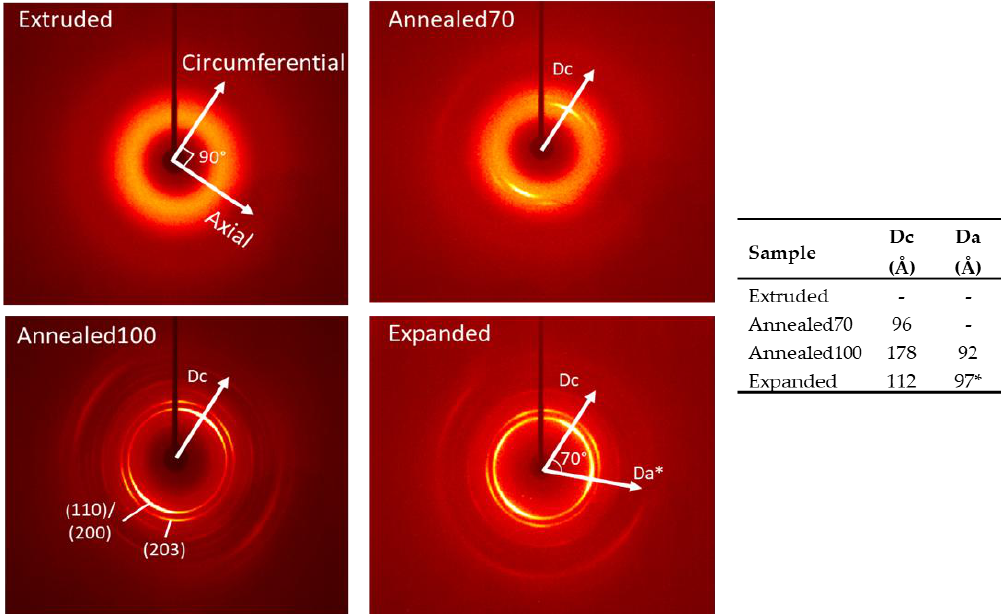
Figure 6. 2D-WAXS (Wide Angle X-Ray Scattering) patterns of the Extruded, Annealed70, Annealed100 and Expanded tubing, plus the calculated crystal size in circumferential (Dc) and axial (Da) directions. Note: The Da* direction in the Expanded tube is offset 70° to the Dc direction.